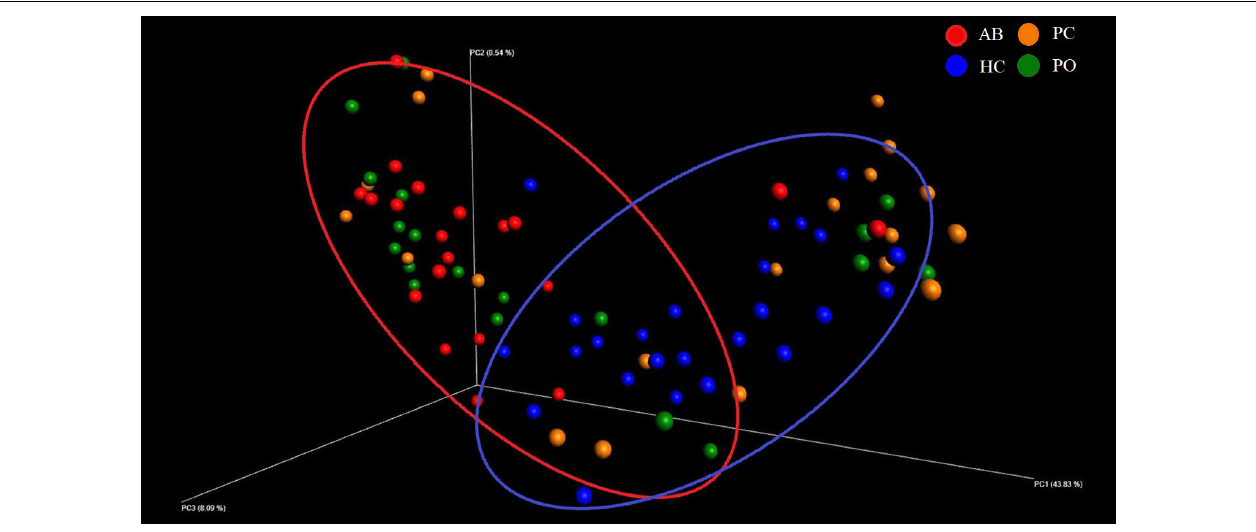
FIGURE 1 | Beta diversity analysis based on UniFrac analysis. Plots were generated using weighted UniFrac distances. Red dot represents the abscess pus (AB) group. Green dot represents the pocket (PO) group. Yellow dot represents the patient control (PC) group. Blue dot represents the healthy control (HC) group. Circles in red and blue represent different periodontal bacterial community clusters,